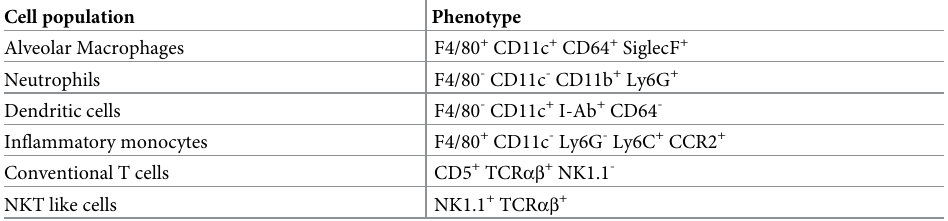
Table 1. Phenotype of the major cell populations identified in this